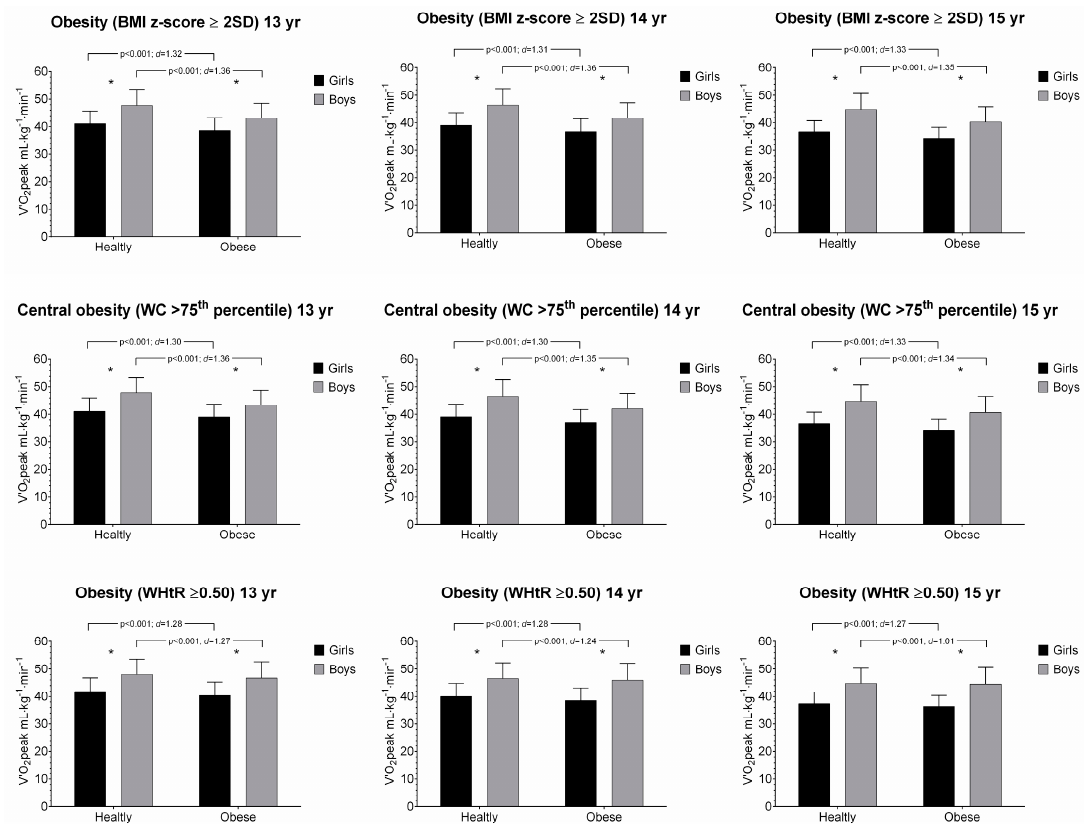
Figure 1. Relative peak oxygen uptake ( 𝑉(cid:4662) O 2 peak) and anthropometric parameters (BMI z-score, waist circumference (WC) and waist-to-height ratio (WHtR)) by age and sex group. Values are mean and standard deviation (SD). * p < 0.001 for sex.